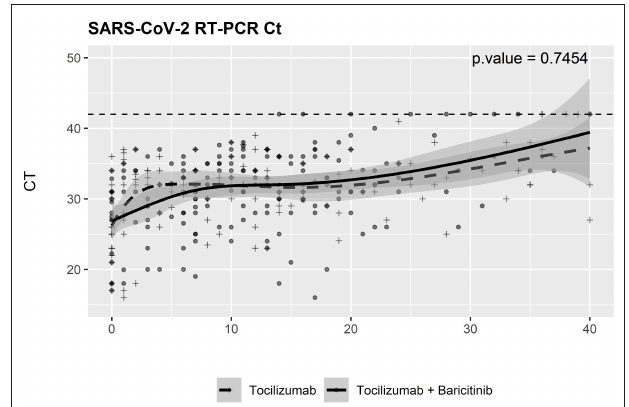
FIGURE 3 | Severe acute respiratory syndrome coronavirus 2 (SARS-CoV-2) virological changes during a follow-up. SARS-CoV-2 RT-PCR test cycle threshold results were obtained from baseline. RT-PCR, reverse transcriptase-PCR; Ct, cycle threshold.